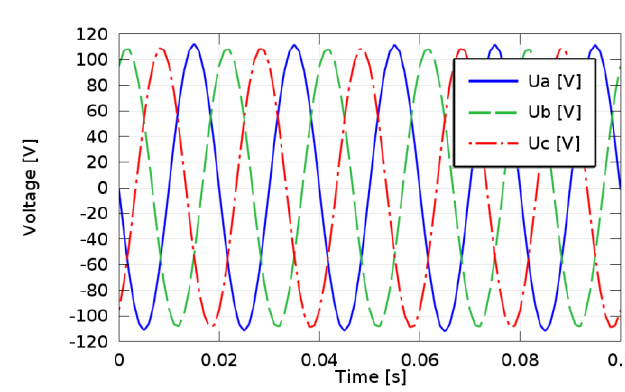
Fig. 7. The induced voltage for each phase, 104max,  iU V.